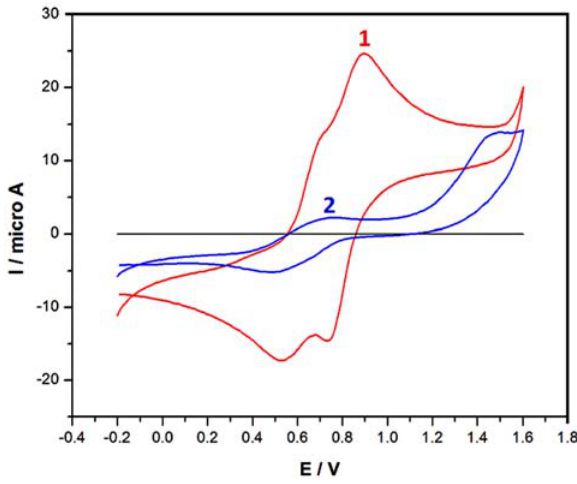
Figure 4. Cyclic voltammograms of the complexes 1 and 2 in a 0.1 M TBAP acetonitrile solution at 300 K and 100